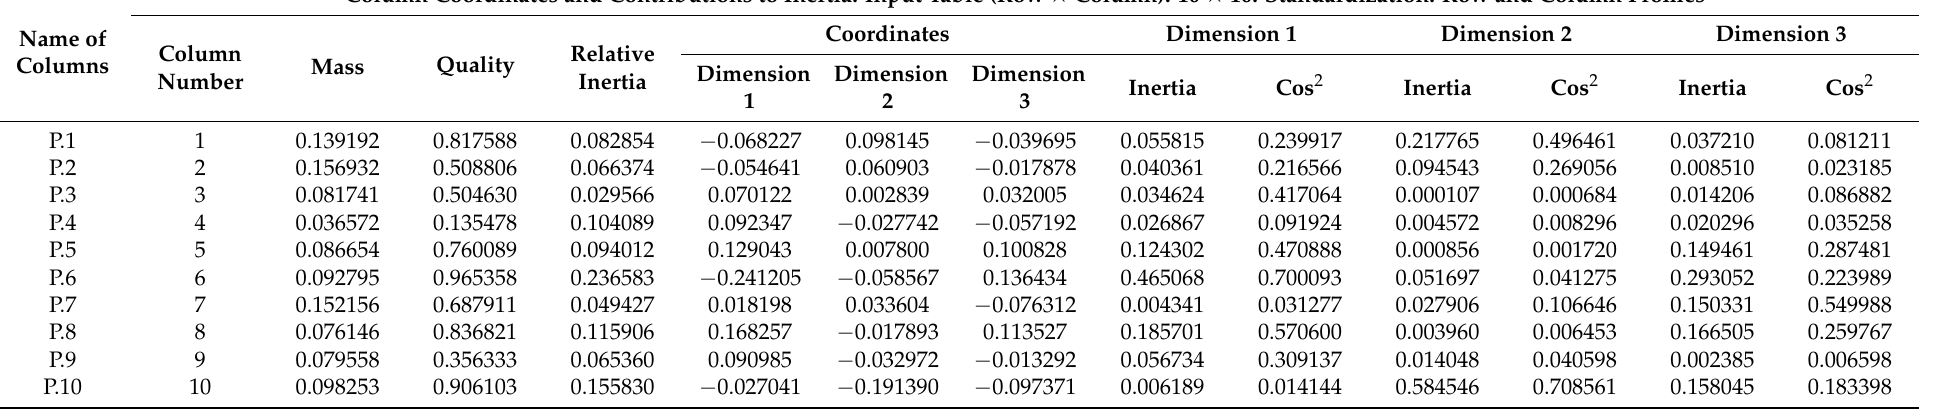
Table 5. Column coordinates and the statistics of the quality of the